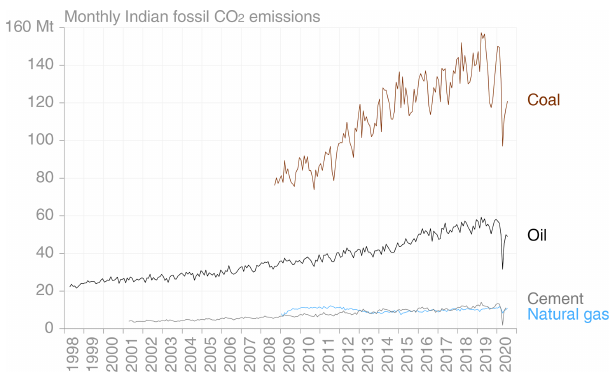
Figure 1. Final monthly CO 2 emissions by category. Trends in coal, oil, and natural gas are given up until the end of July 2020, and the trend in cement is given up until the end of June 2020. Source: Own calculations.